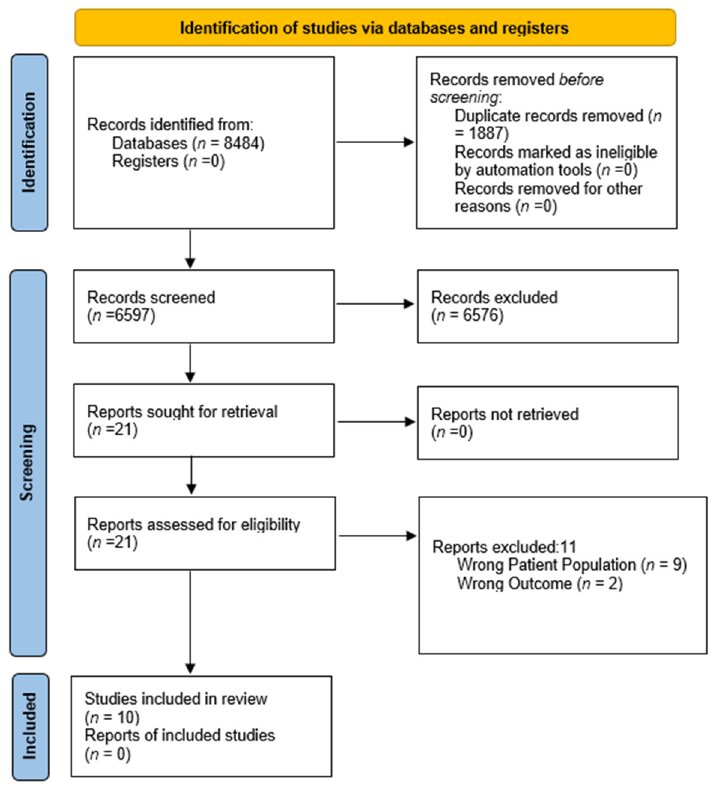
Figure 1. PRISMA flow diagram.